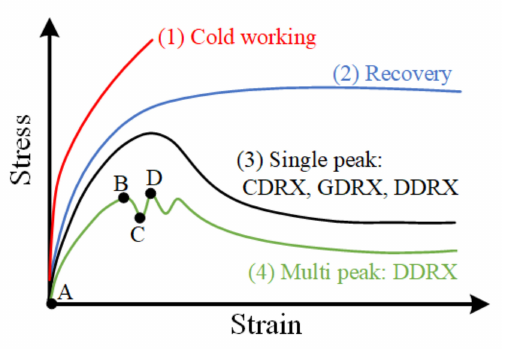
Figure 11. Schematic illustration of the flow stress behaviour with di ff erent